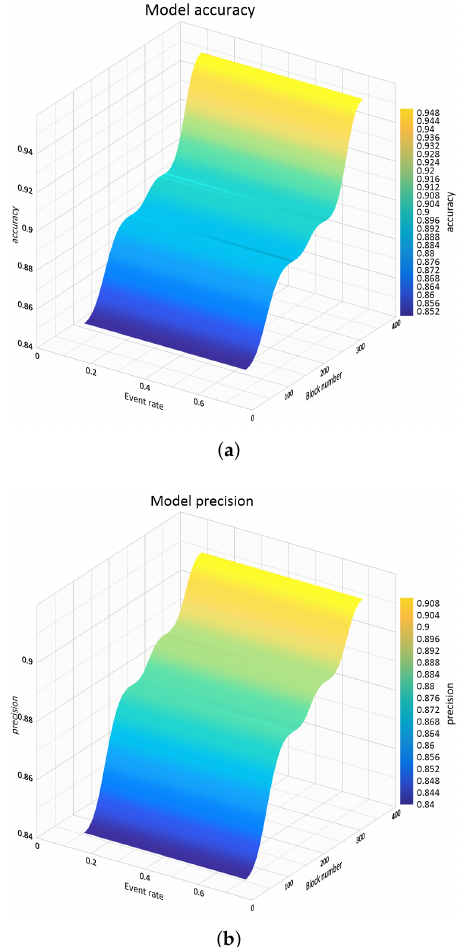
Figure 12. Accuracy and precision of the proposed system for different event rates and number of generated blocks. ( a ) Model accuracy; ( b ) Model